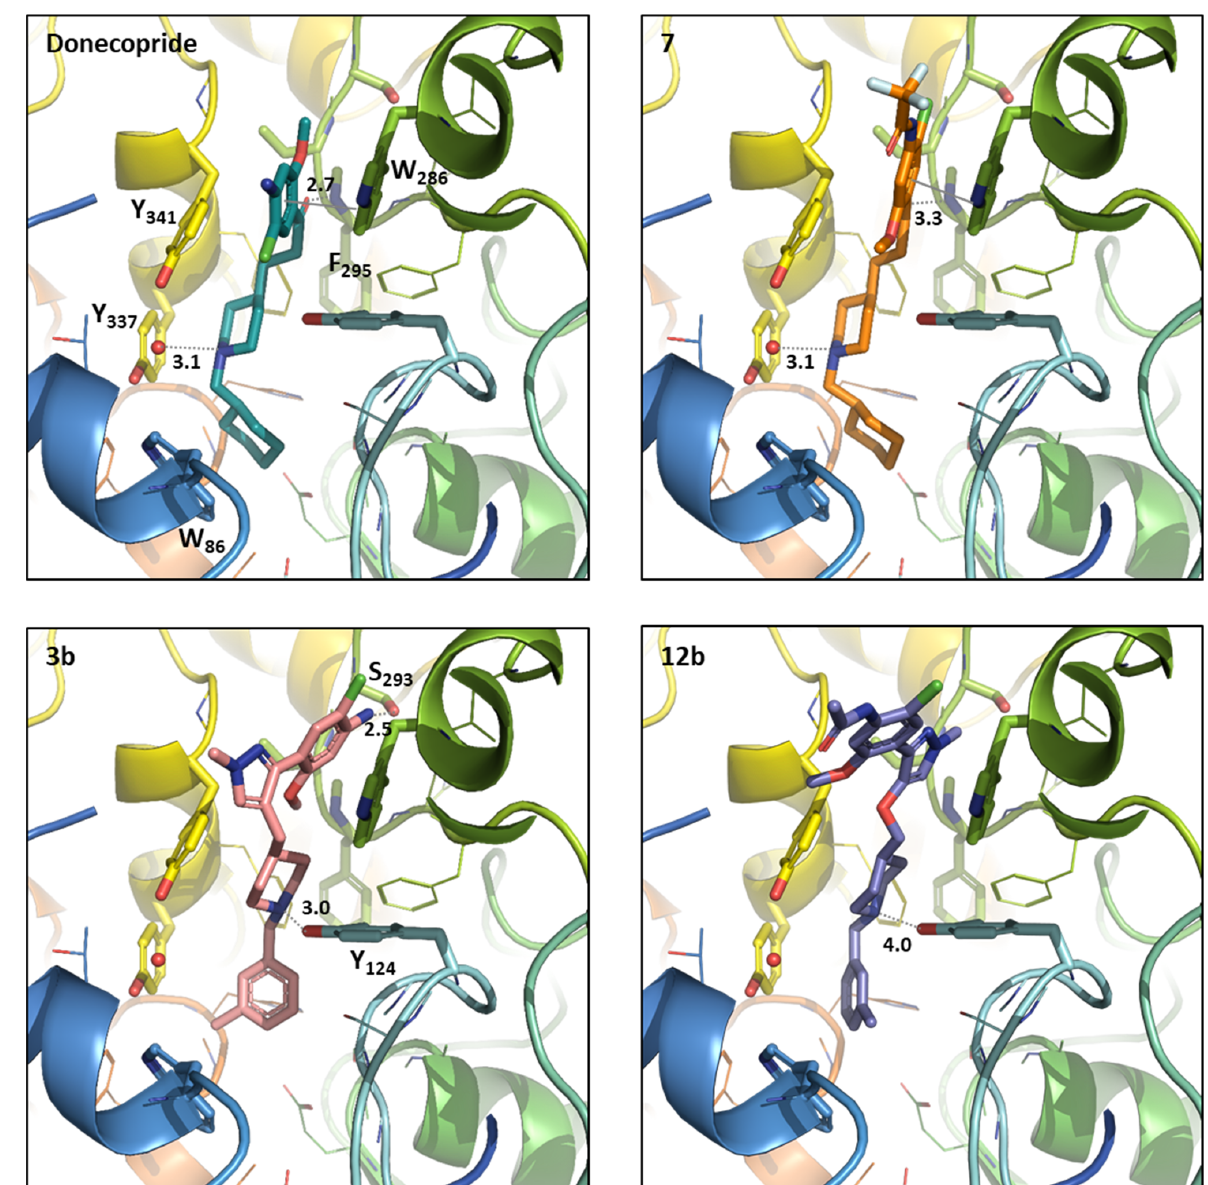
Figure 2. Donecopride (green) position compared to the compound 7 (orange), 3b (pink), and 12b (purple) positioned in h AChE binding sites using the docking studies. The compound and the selected side chains of the binding site residues are in stick and the protein in ribbon representation. This figure was made with PYMOL (DeLano Scientific, South San Francisco, CA, USA, 2002, San Carlo, Redwood City, CA, USA) and the protein is presented in the same orientation in all four images.